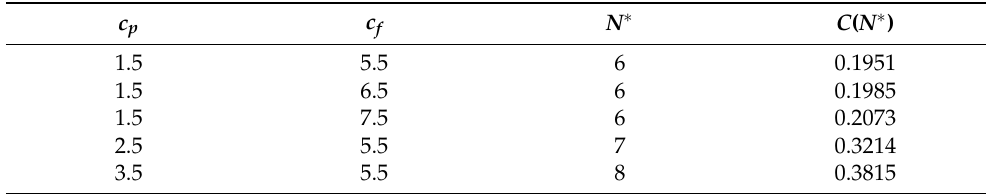
Table 4. Optimal solution with different values of cost parameters when n = 5, k = 2, p = 0.45, δ = 2, m 1 =